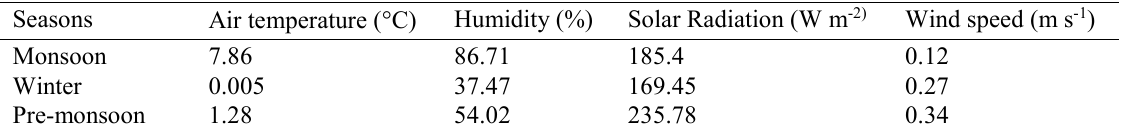
Table 1 Mean value of air temperature, relative humidity, solar radiation and wind speed during monsoon, winter and pre-monsoon